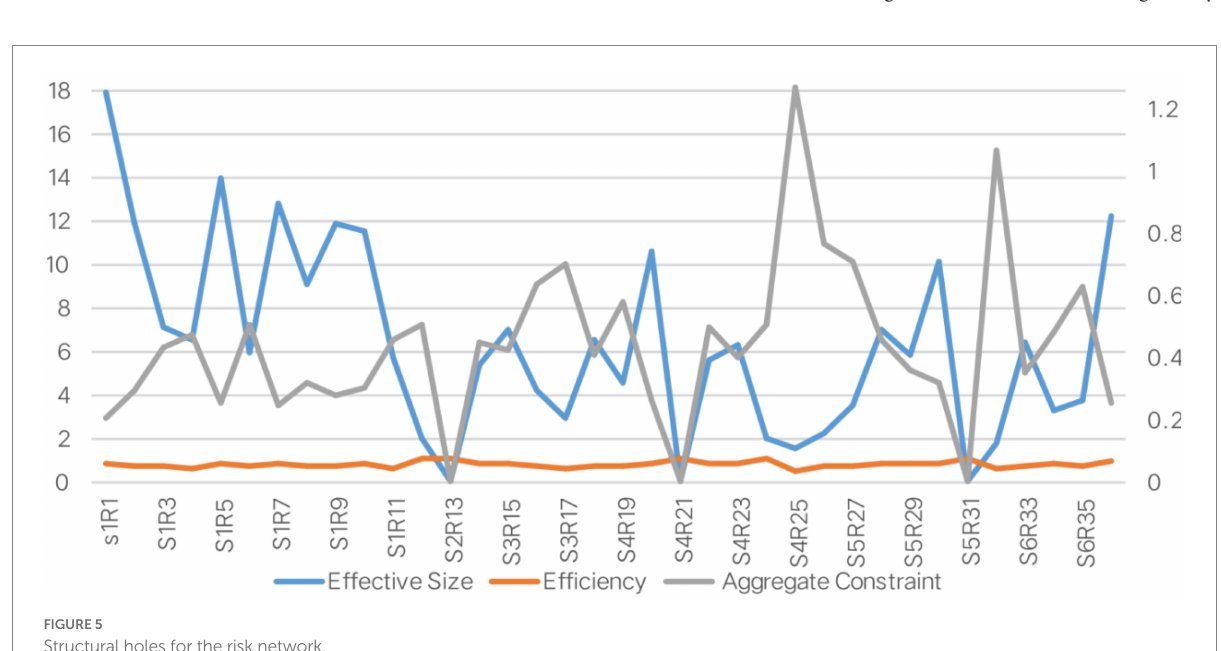
FIGURE 5 Structural holes for the risk